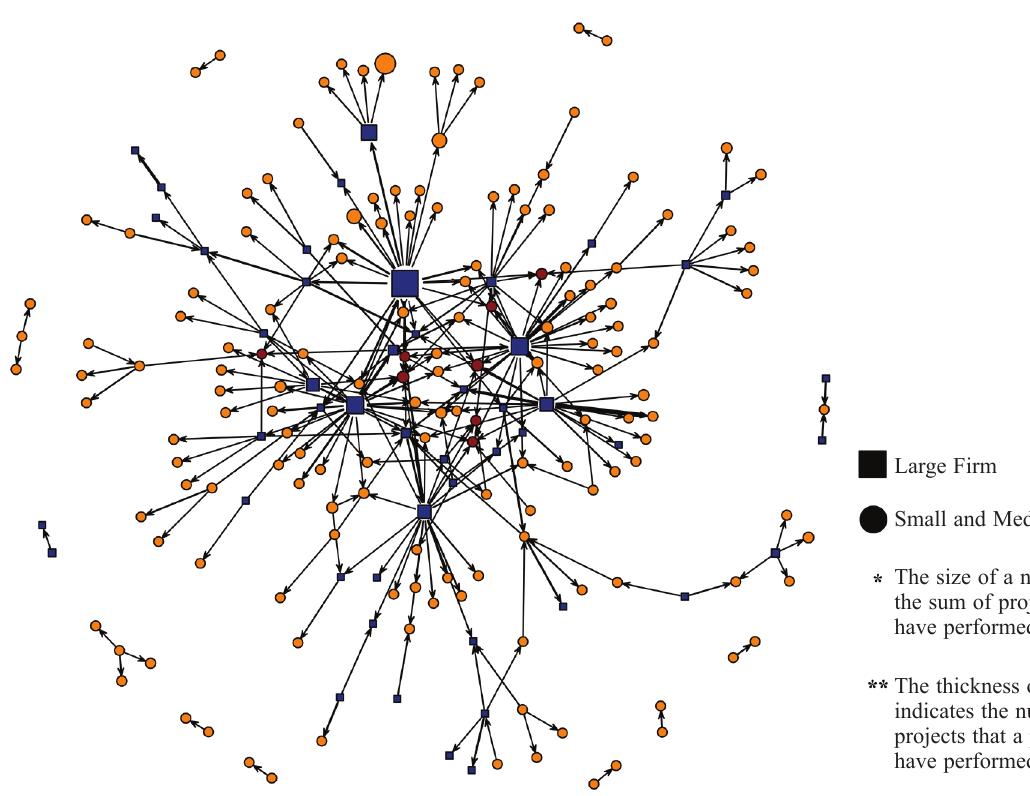
Fig. 3. Sociogram of inter-firm network